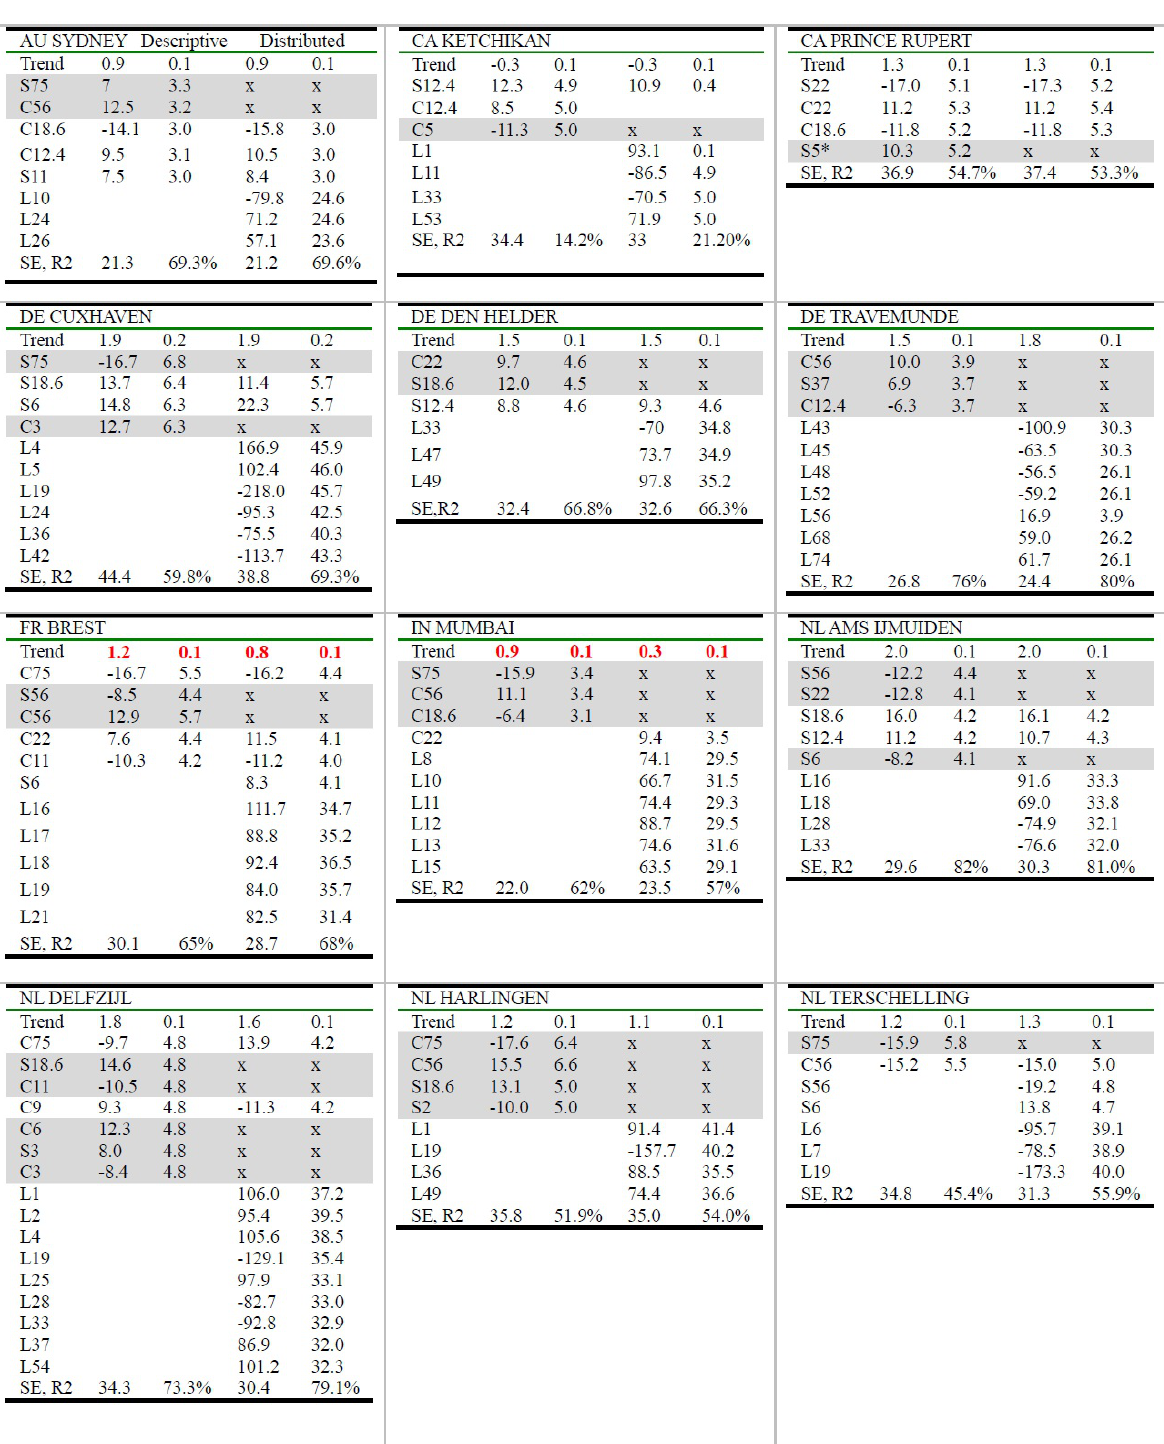
Table 1: First column in each sub-table refers to the parameters designations: Trend is in mm/y, S and C stands for the coeeficients of Sine and Cosine components of the periodicities (in mm) joined by the period in years. Colums 2 and 3 are the estimated and the corresponding standard deviations for the descriptive model solutions. Colums 4 and 5 refers to the Distributed lag model solutions. All the parameters are statistically significant at 5 percent level. The mean square error (a posteriori variance of unit weight) and the adjusted R 2 values for each model are tabulated on the last row of each sub-table. The common parameters that are not statistically significant in the distributed lag model solutions (crossed) but not in the descriptive model are shaded. The parameters with blank cells are not included in the descrip- tive model solutions. Trends from both solutions are marked in red color if they are statistically significant different from each other at 5 percent level (A word of caution: this statement about the statistical significance is not strictly correct because both model solutions are using the same data set, i.e. the estimates and their standard errors are not